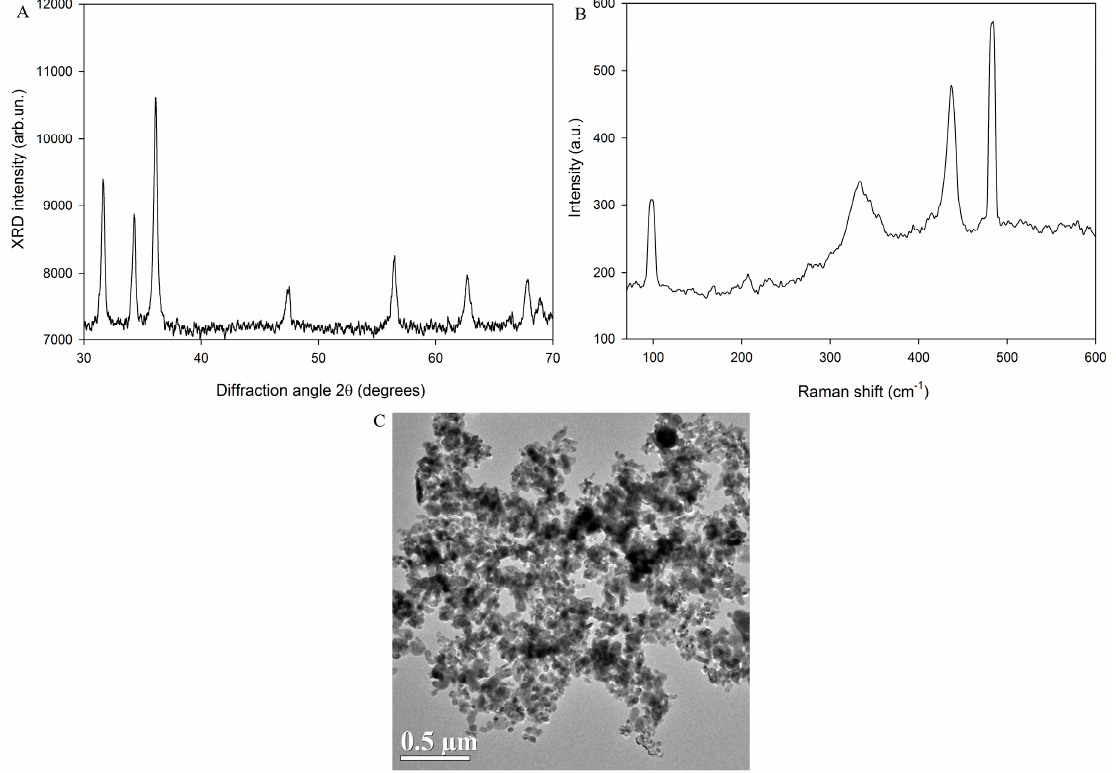
Figure 1. Characteristics of ZnO NPs (code: XFI06). ( A ) the XRD spectrum of ZnO NPs. ( B ) the Raman spectrum of ZnO NPs. ( C ) TEM picture of ZnO NPs.